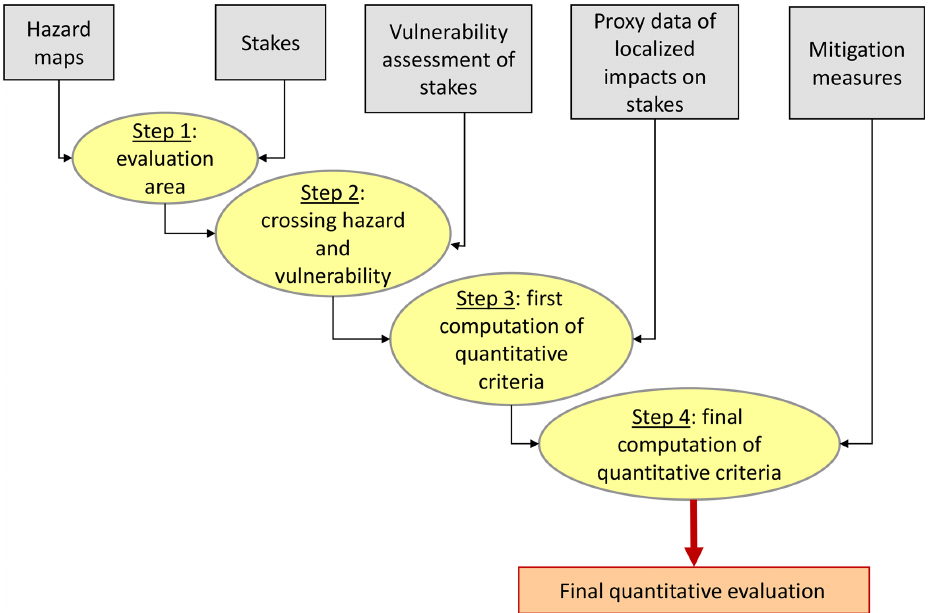
Figure 2. Scheme of the evaluation methodology to assess the relevance of susceptibility maps to runoff, using localized runoff-related impact proxy data. The grey boxes indicate the information that is used in the various steps of the methodology. Yellow circles present the various steps of the evaluation methodology leading to the final quantitative evaluation (orange